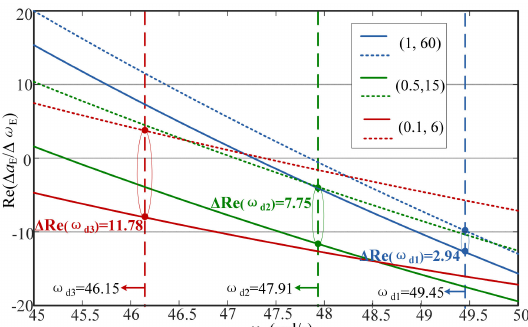
Figure 13. Impacts of di ff erent TVC controller parameters ( k p2 , k i2 ) on the frequency responses of the real part of the transfer function ∆ a E / ∆ ω E . (The dotted lines are cases ignoring the e ff ect of frequency variation, and the solid lines represent cases where it is considered. ∆ Re( ω d ) is the di ff erence between the values of Re[ ∆ a E / ∆ ω E ( j ω d )] of them.).